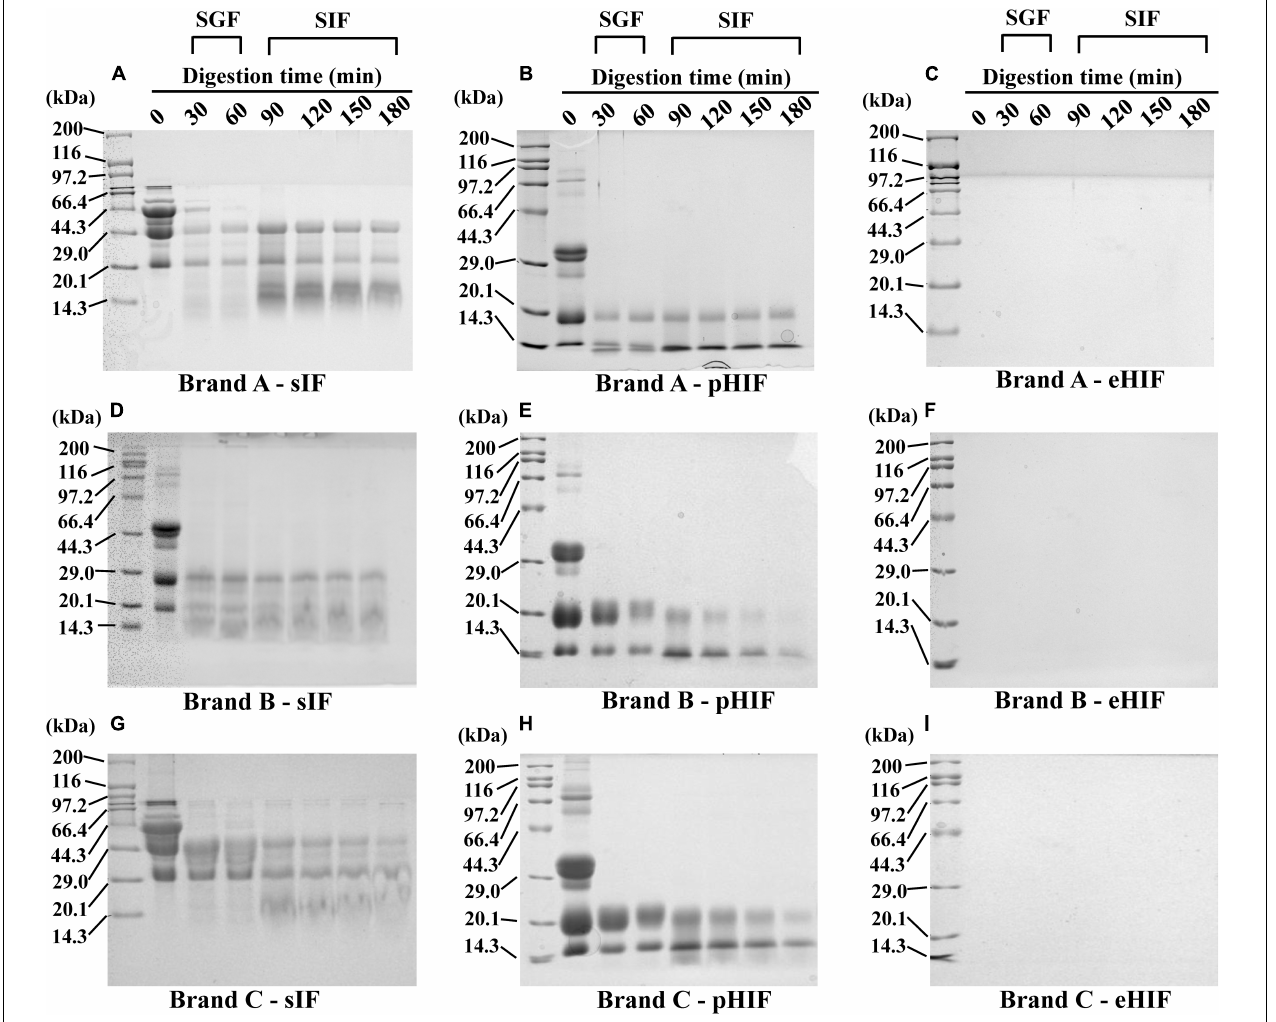
FIGURE 1 | SDS–PAGE. (A–C) Represent protein electrophoresis of the brand A of the sIF, pHIF, and eHIF after SGF and SIF digestion, respectively. (D–F) Represent protein electrophoresis of the brand B of the sIF, pHIF, and eHIF after SGF and SIF digestion, respectively. (G–I) Represent the protein electrophoresis of the brand C of the sIF, pHIF, and eHIF after SGF and SIF digestion, respectively.